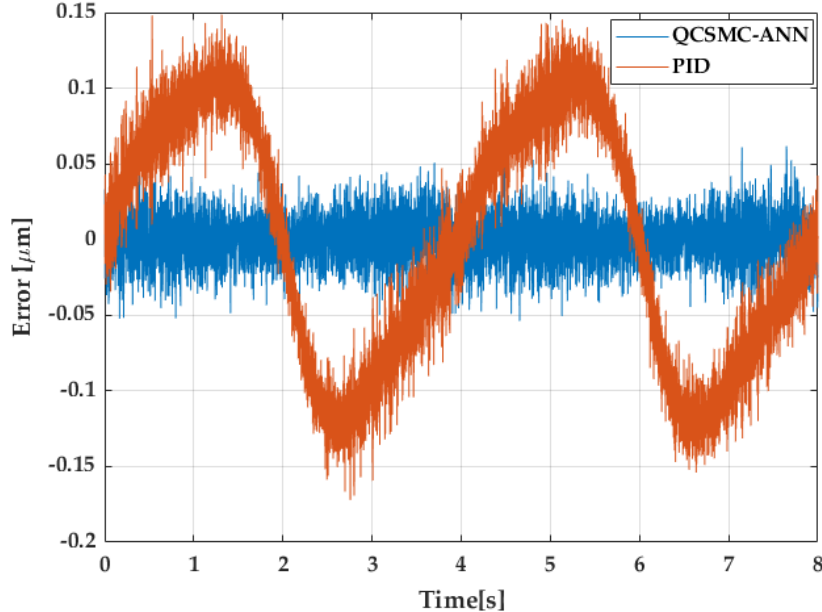
Figure 8. The error generated in 2 cycles of a sine wave reference.